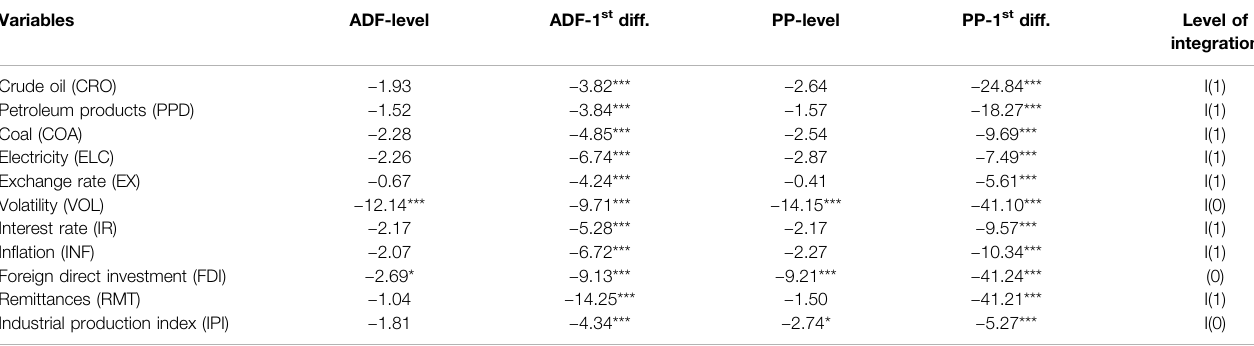
TABLE 1 | Unit root test results. Variables ADF-level ADF-1 st diff. PP-level PP-1 st diff. Level of